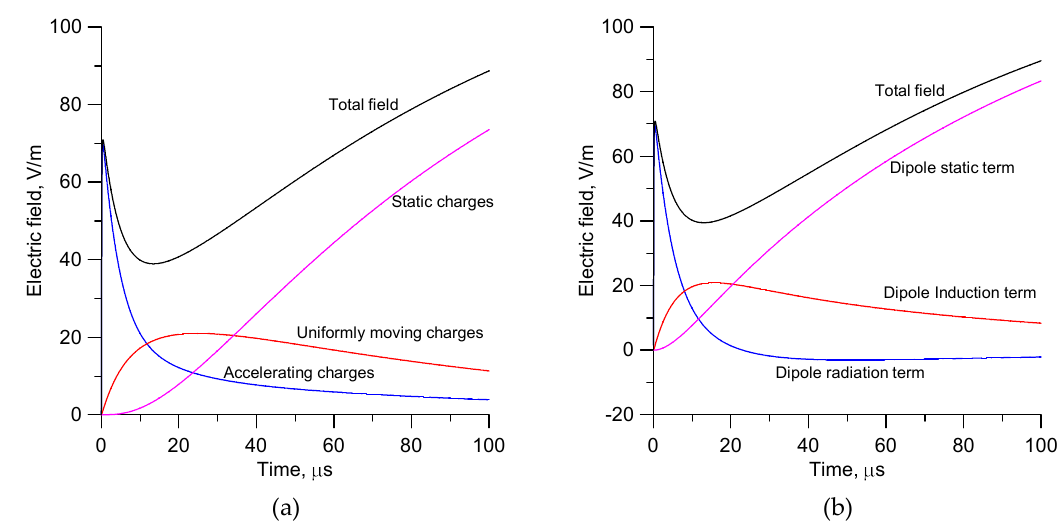
Figure 3. ( a ) The three field components and the total field associated with accelerating and moving charges, and ( b ) the three field components and the total field associated with dipole fields. The electric fields at 5 km distance from a lightning channel are obtained using the MTLE model with a 12 kA current, 1.5 × 10 8 m/s return stroke speed and 2 km current decay height constant. Note that in depicting the electric fields, the field components directed into the ground (i.e., directed along the negative z-axis) are considered positive.